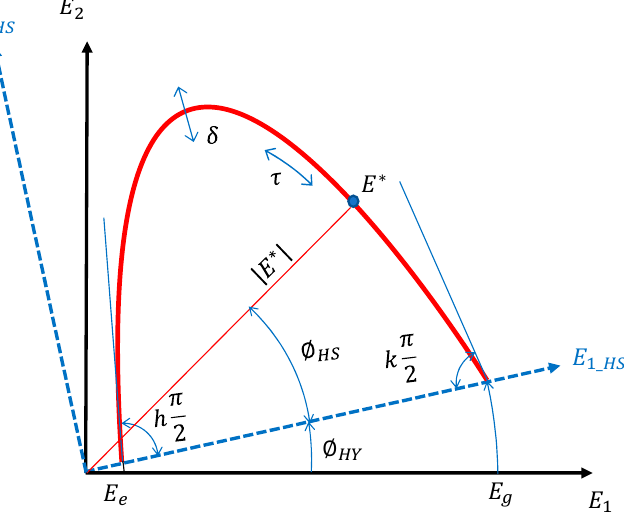
Figure 14. Comparison between the Huet–Sayegh (HS) and HS-HY model.